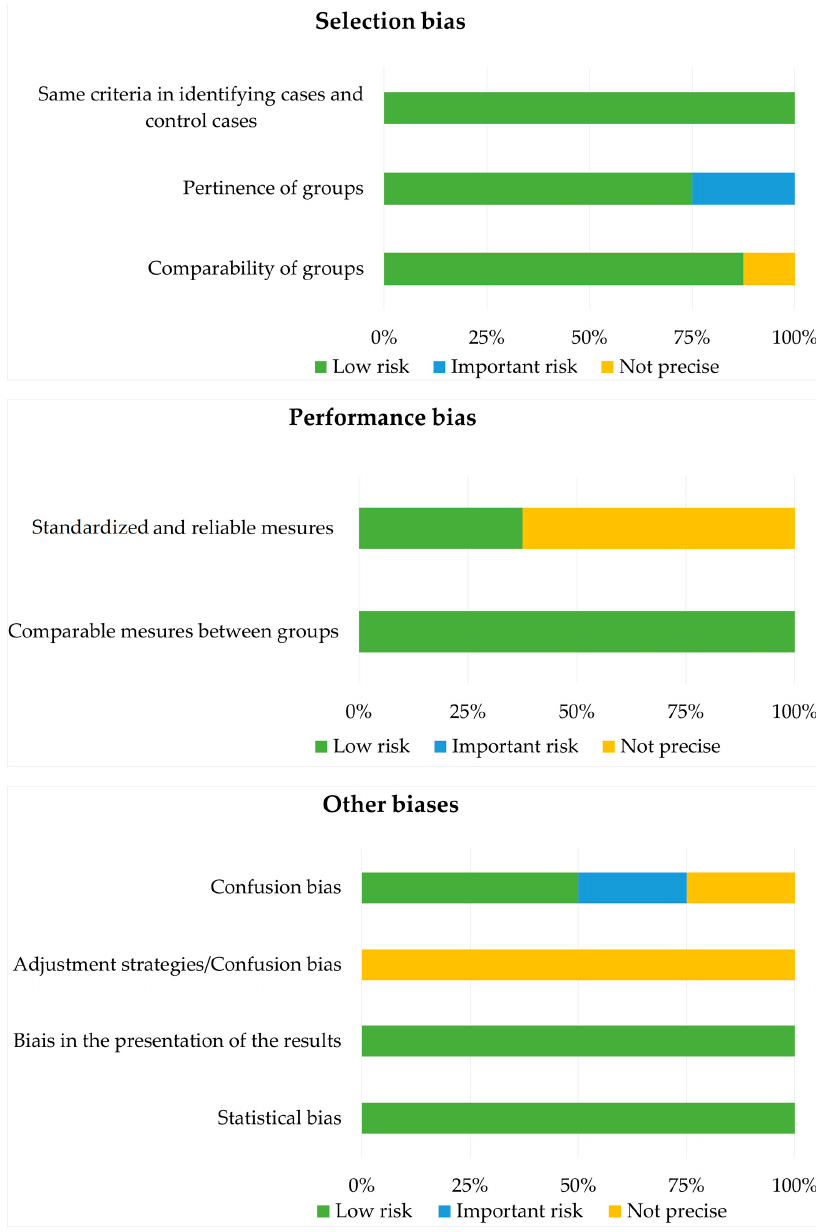
Figure 2. Risk of bias analysis with the Joanna Briggs Institute case ‒ control study checklist.